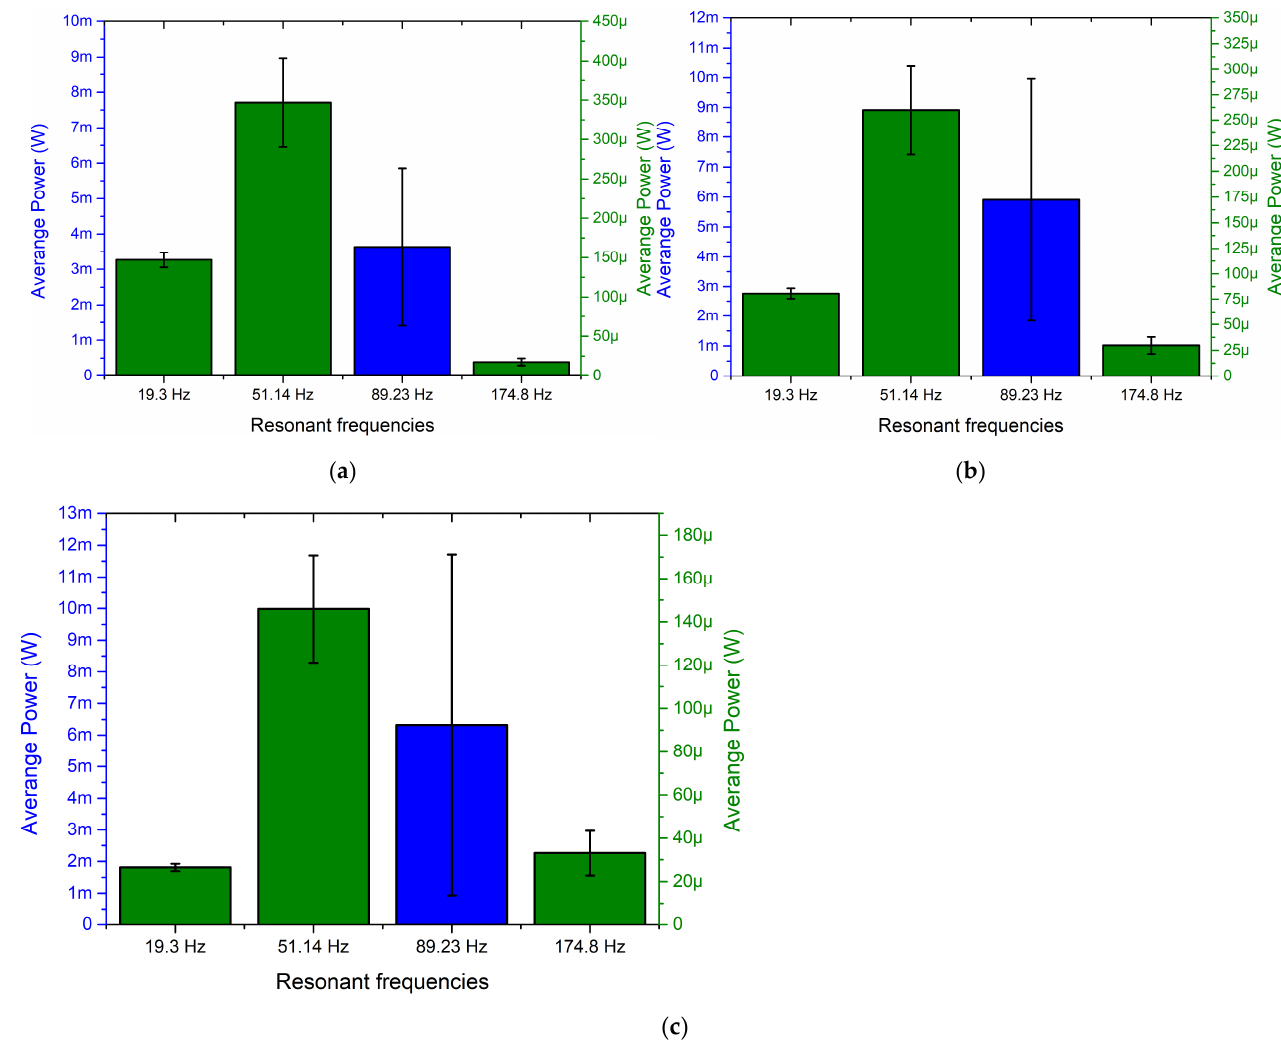
Figure 11. Summary of average output power at resonance frequencies while different loads are used; ( a )—load equal to 1 MΩ; ( b )—load equal to 500 kΩ; ( c )—load equal to 250 kΩ.